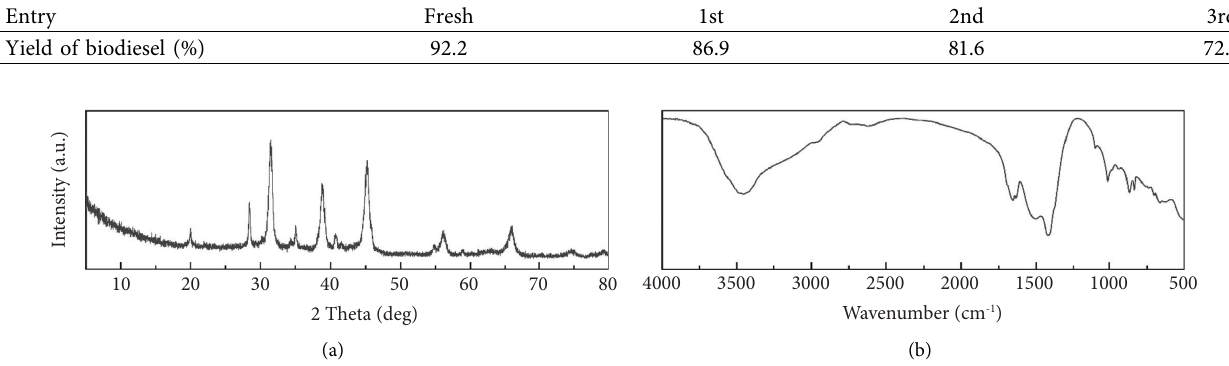
Figure 7: XRD pattern and FT-IR curve for the catalyst after 3 reused